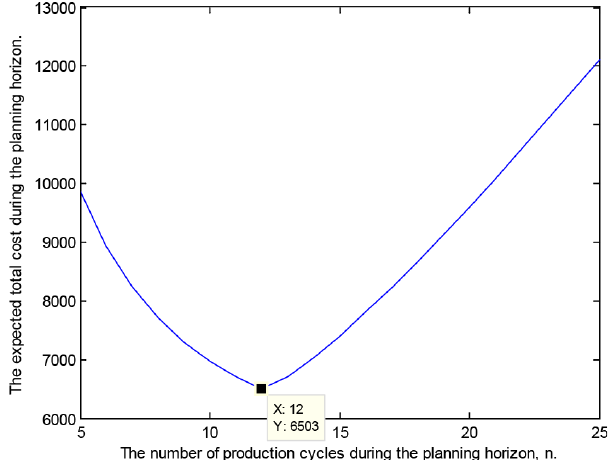
Figure 3. Excepted total costs of Equation